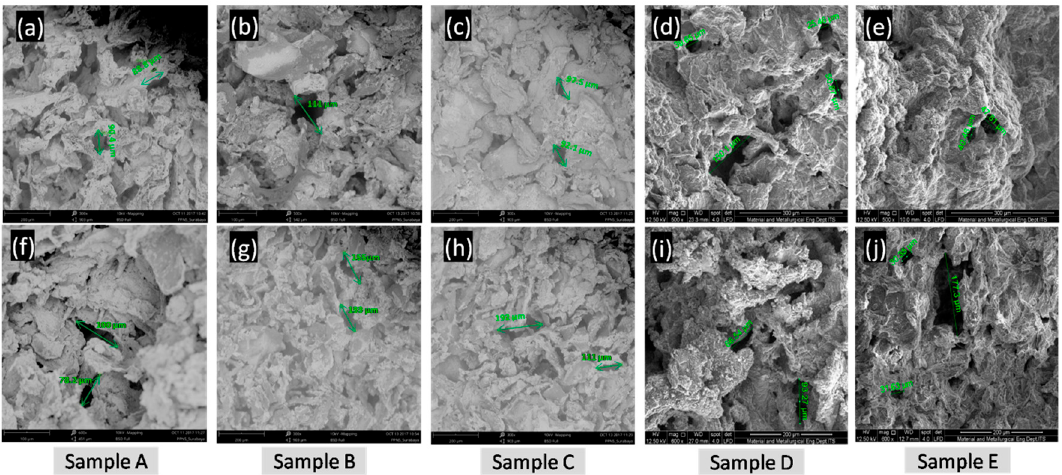
Figure 3. The surface ( a – e ) and cross-sectional ( f – j ) SEM results of the nanocomposite-based scaffold n-HA/Ch/CMC, having average pore sizes of ~100 µm.